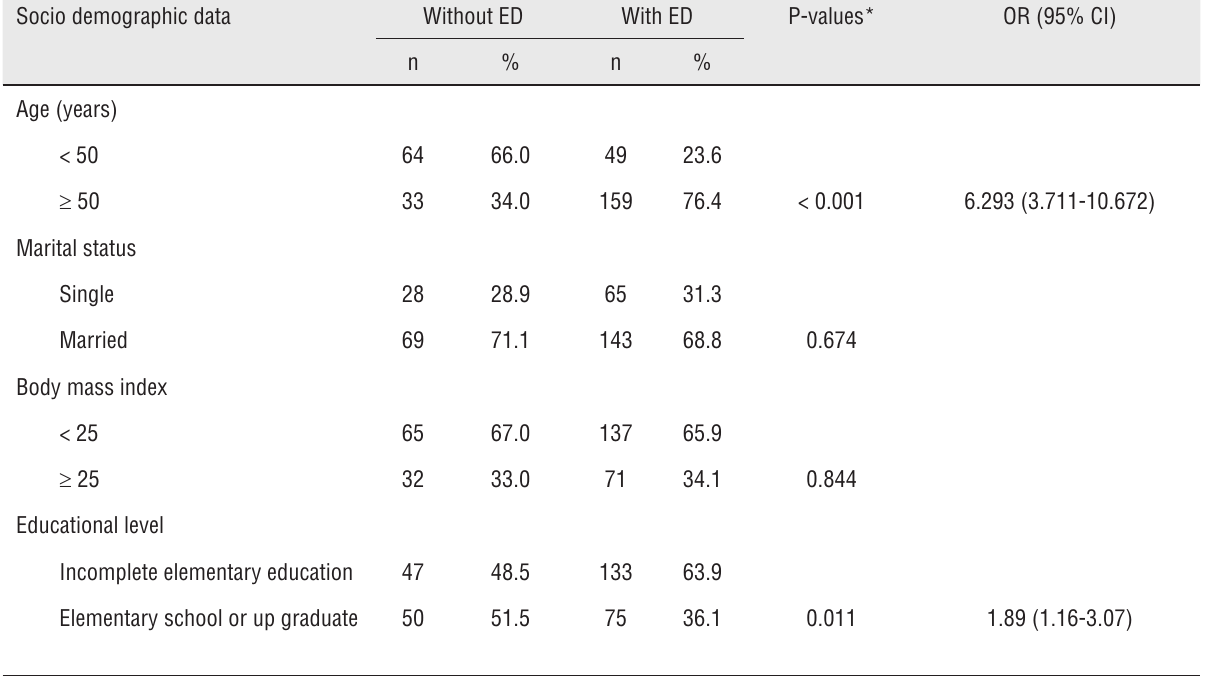
Table 1 - Association of socio demographic data with Erectile Dysfunction in hemodialysis patients. Socio demographic data Without